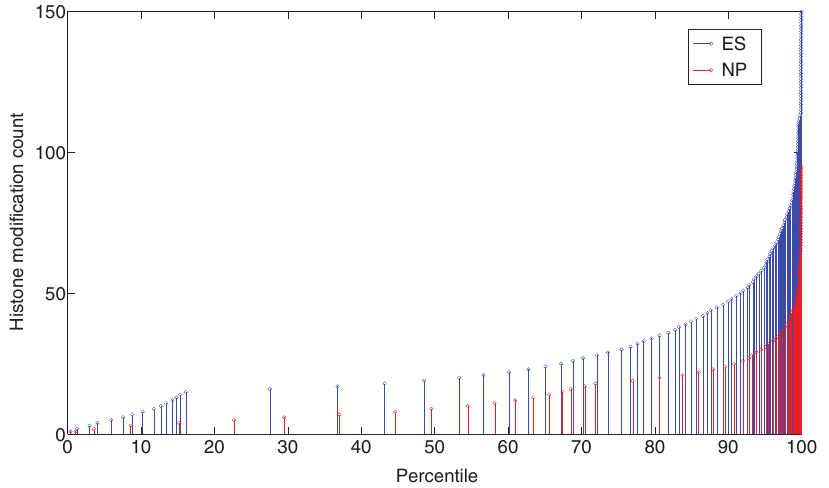
Figure 3. The new inverse cumulative distribution function on the modified libraries (after stage 1). On the x axis is the percentile, on the y axis are the bin values.